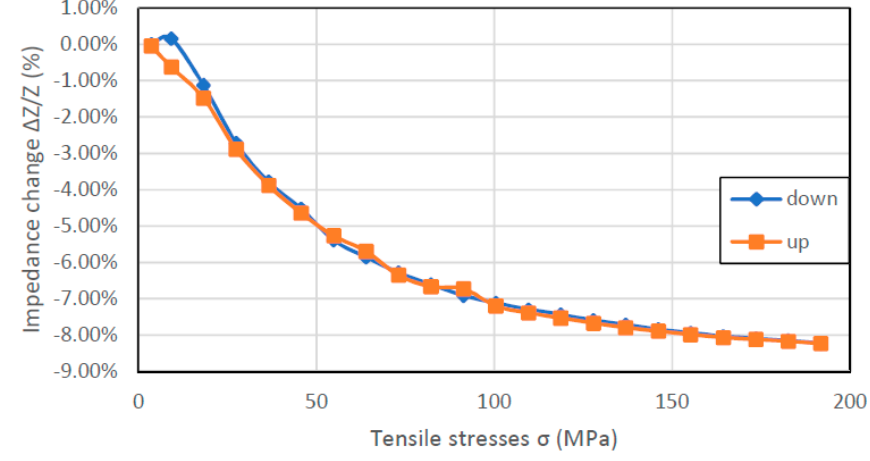
Figure 7. Hysteresis SI measurements of Fe 40 Ni 38 Mo 4 B 18 sample (for 1 MHz driving signal).